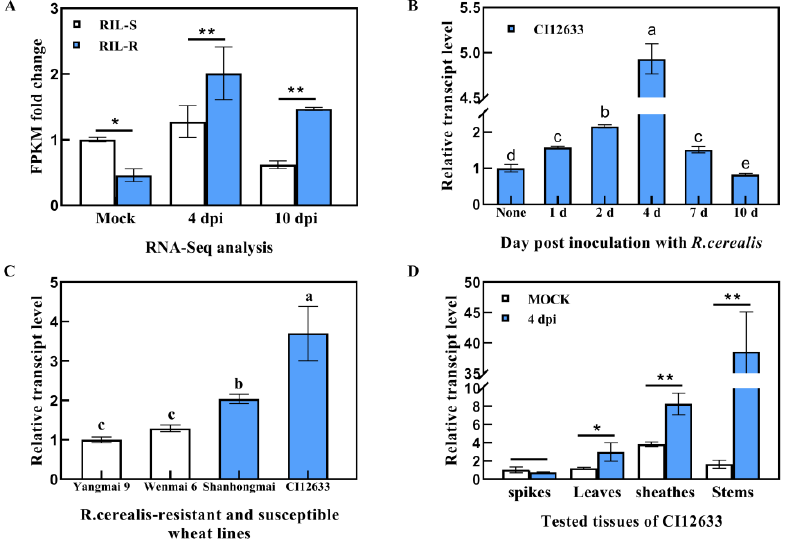
Figure 1. Transcript profiles of TaWAK7D responding to Rhizoctonia cerealis in wheat. ( A ) The transcriptional level of TaWAK7D was obviously increasing in the resistant lines (RIL-R) than in the susceptible lines (RIL-S) at 4 and 10 dpi with R. cerealis . The expression level of TaWAK7D in RIL-S plants at mock was set to 1. ( B ) Transcript profiles of TaWAK7D in R. cerealis -resistant wheat line CI12633 at none, 1, 2, 4, 7 and 10 dpi with R. cerealis Rc207. TaWAK7D transcript level of none was set to 1. ( C ) Expression patterns of TaWAK7D in four wheat cultivars with different resistance degrees at 4 dpi with R. cerealis . The expression level of TaWAK7D in Yangmai 9 was set to 1. ( D ) Expression pattern of TaWAK7D in spikes, leaves, sheathes and stems of CI12633 at 4 dpi with R. cerealis or mock. The transcriptional level of TaWAK7D in spikes with mock treatment was set to 1. TaActin was used as the internal control. Significant differences were determined based on three technical repeats (Student’s t-test: * p < 0.05; ** p < 0.01). Bars indicate the standard error of the mean.